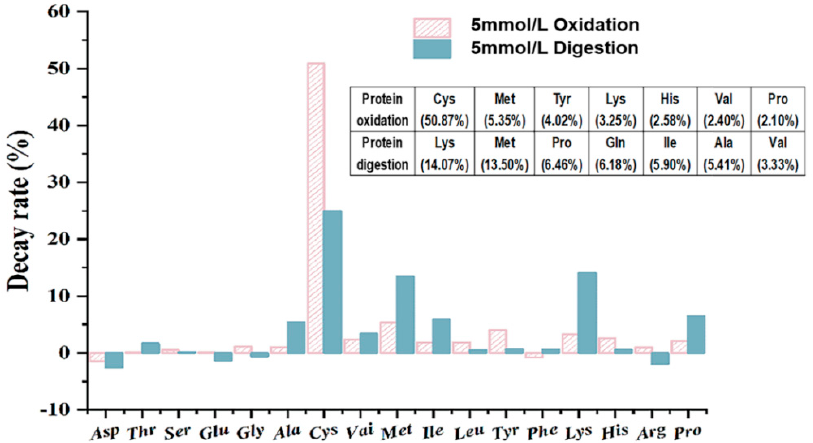
Figure 5. The decay rate of 17 amino acids for walnut isolated proteins after AAPH oxidation and digestion for 2 h at the concentration of AAPH is 5 mmol/L, respectively. digestion for 2 h at the concentration of AAPH is 5 mmol/L,